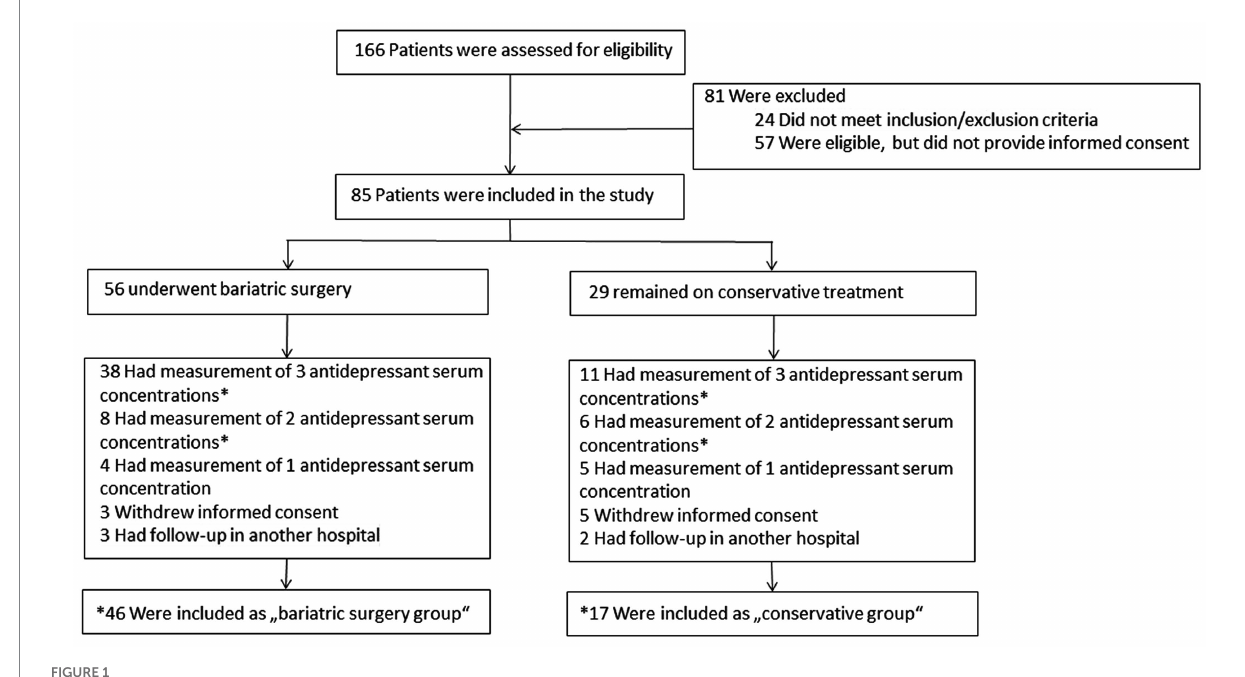
FIGURE 1 Enrollment and *inclusion of the final